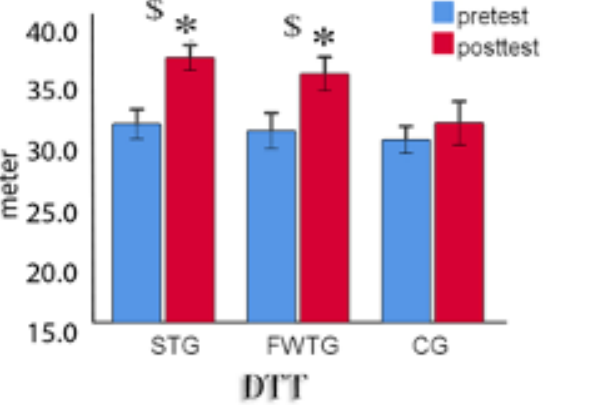
Figure 5. The effects of training intervention on DTT. *significant difference from pre-test, $ significant difference from the